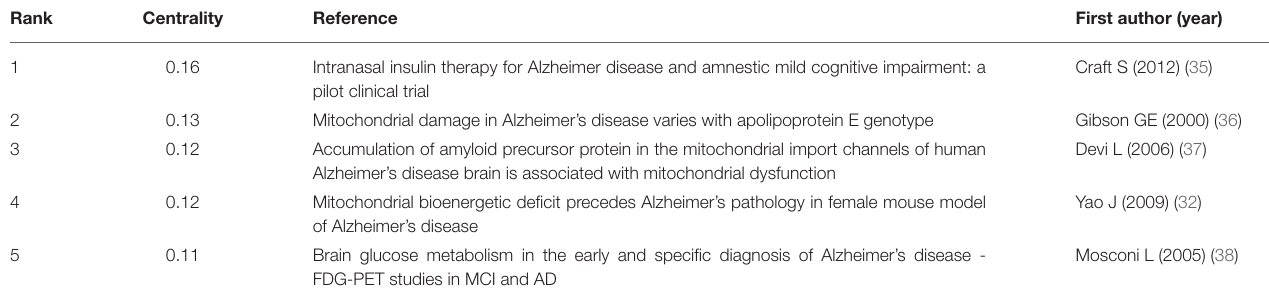
TABLE 7 | Top five references with the best